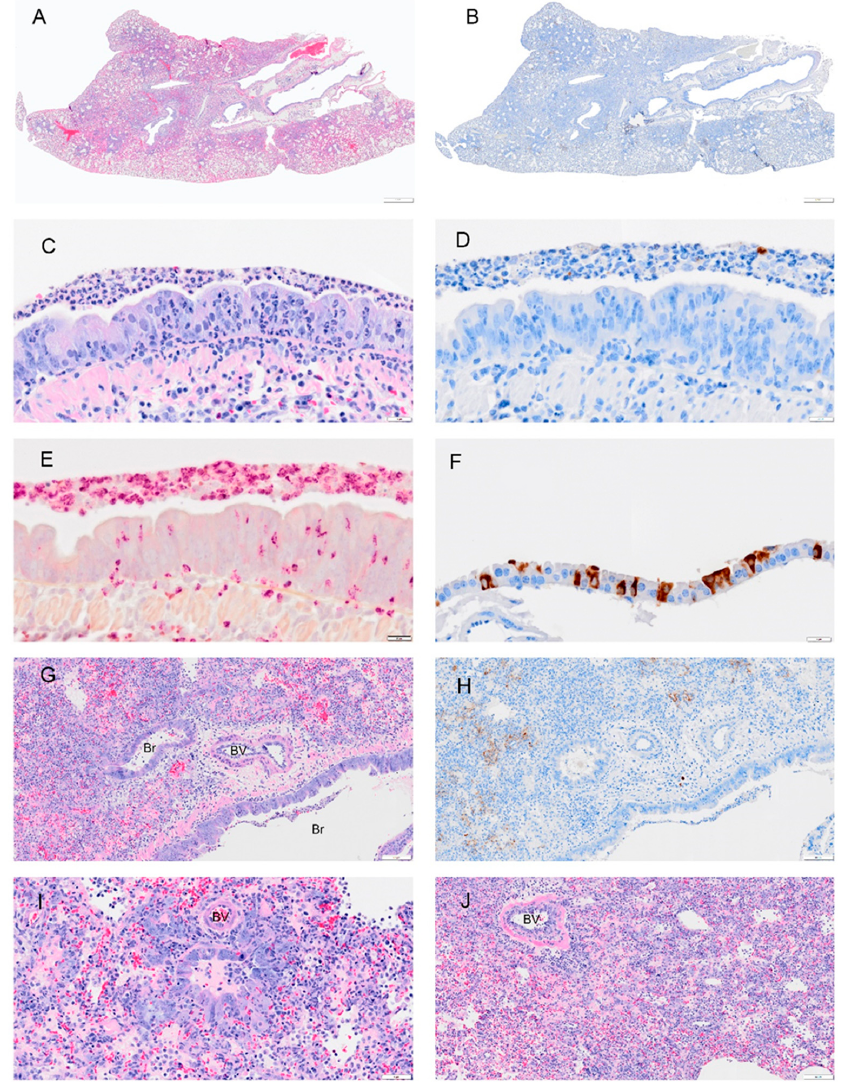
Figure 7. Selected pathology and immunohistochemistry of lungs from Syrian hamsters at day 4 post-infection with SARS-CoV-2. ( A ) Section of the lung shows more extensive consolidation. ( B ) Image showing overall reduction in viral antigen (not present in bronchi). ( C ) Higher magnification of bronchus shows decreased debris in bronchial lumen, abundant neutrophil infiltration in hyperplastic (and disorganized) epithelium and submucosa. ( D ) A serial section adjacent to ( C ) shows minimal viral antigen in epithelial layer and debris. ( E ) An adjacent serial section to ( C , D ), shows neutrophils in debris, epithelial and sub mucosa layer following NACE staining. ( F ) Virus antigen is still present in some bronchiolar epithelial cells. ( G ) H&E-stained section which shows hyperplastic bronchial epithelium with neutrophil infiltration, debris in lumen, necrosis (Br) and inflammatory cells infiltrates in lung parenchyma, a blood vessel with thickened endothelium (BV) and perivascular edema. ( H ) An adjacent serial section to ( G ) shows small pockets of viral antigen in pulmonary parenchyma (consolidation) but not in bronchial epithelium. ( I ) H&E-stained lung tissue shows perivascular (BV) and peri-bronchial inflammatory cell infiltration, alveolar exudates, and alveolar epithelial hyperplasia with mitosis. ( J ) A BV with proliferated endothelial cells Monocytes and eosinophils, and fibroblasts (undergoing mitosis) are distributed around blood vessels. Necrotic lung tissues show damaged alveolar walls and inflammatory cell infiltrates in consolidation area. Bar: ( A , B ) = 1 mm; ( C – F ) = 20 µ m; ( G , H , J ) = 100 µ m; ( I ) = 50 µ